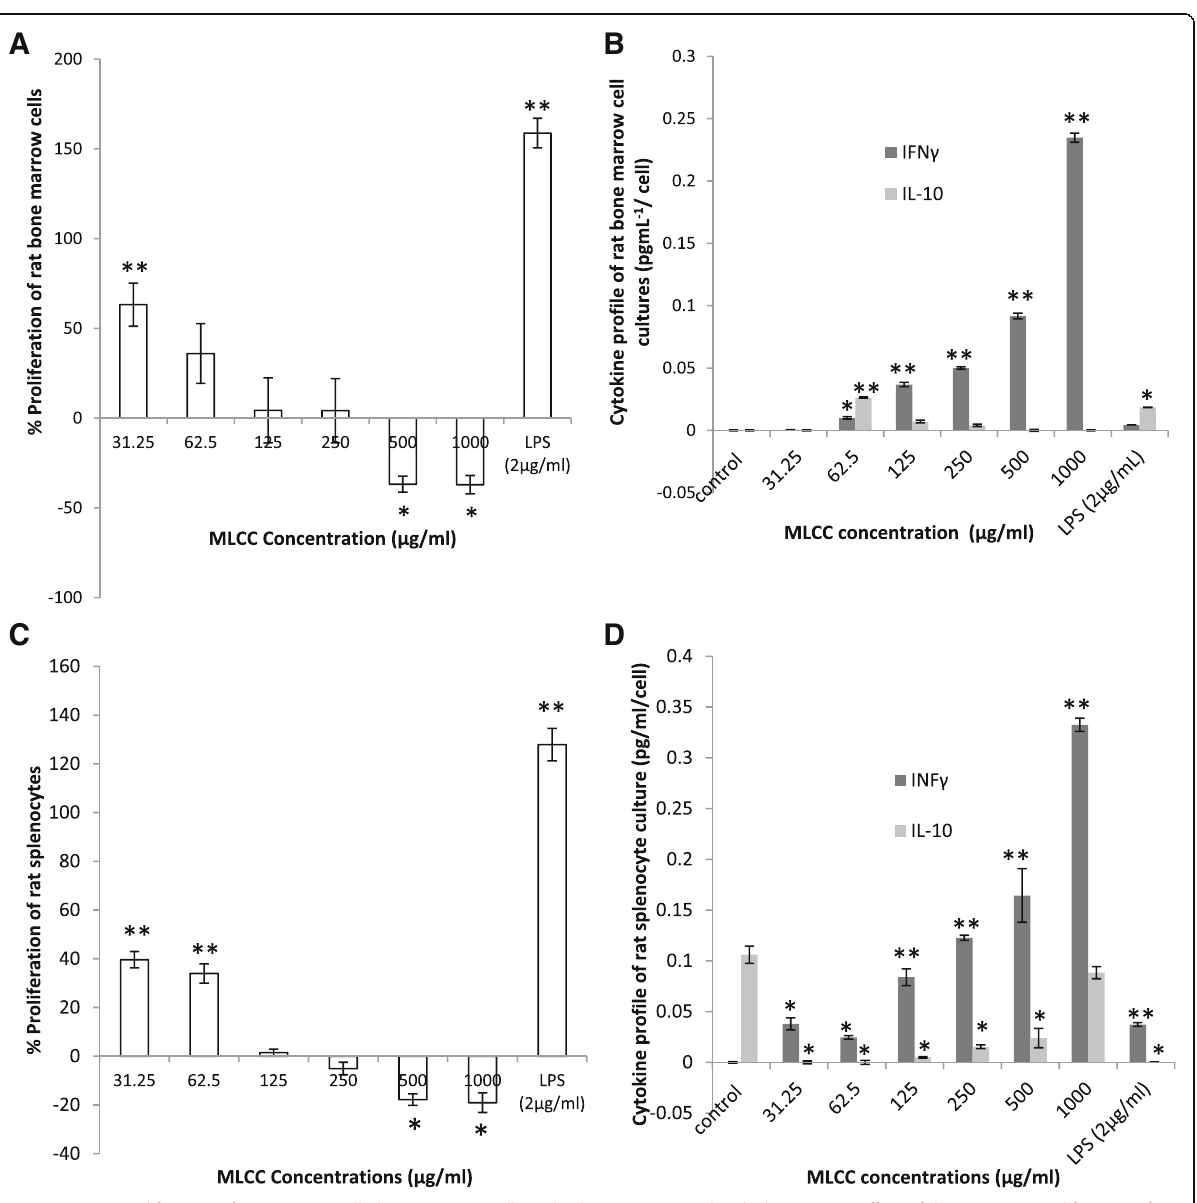
Fig. 5 Ex vivo proliferation of rat immune cells: bone marrow cells and splenocytes treated with the MLCC, a effect of the MLCC on proliferation of bone marrow cells. b effect of the MLCC on cytokine profile of the bone marrow cells, c effect of the MLCC on proliferation of splenocytes. d effect of the MLCC on cytokine profile of the Results are expressed as Mean ± SEM ( n = 3/concentration). * p < 0.05, ** p < 0.01 were considered significant when compared with the control